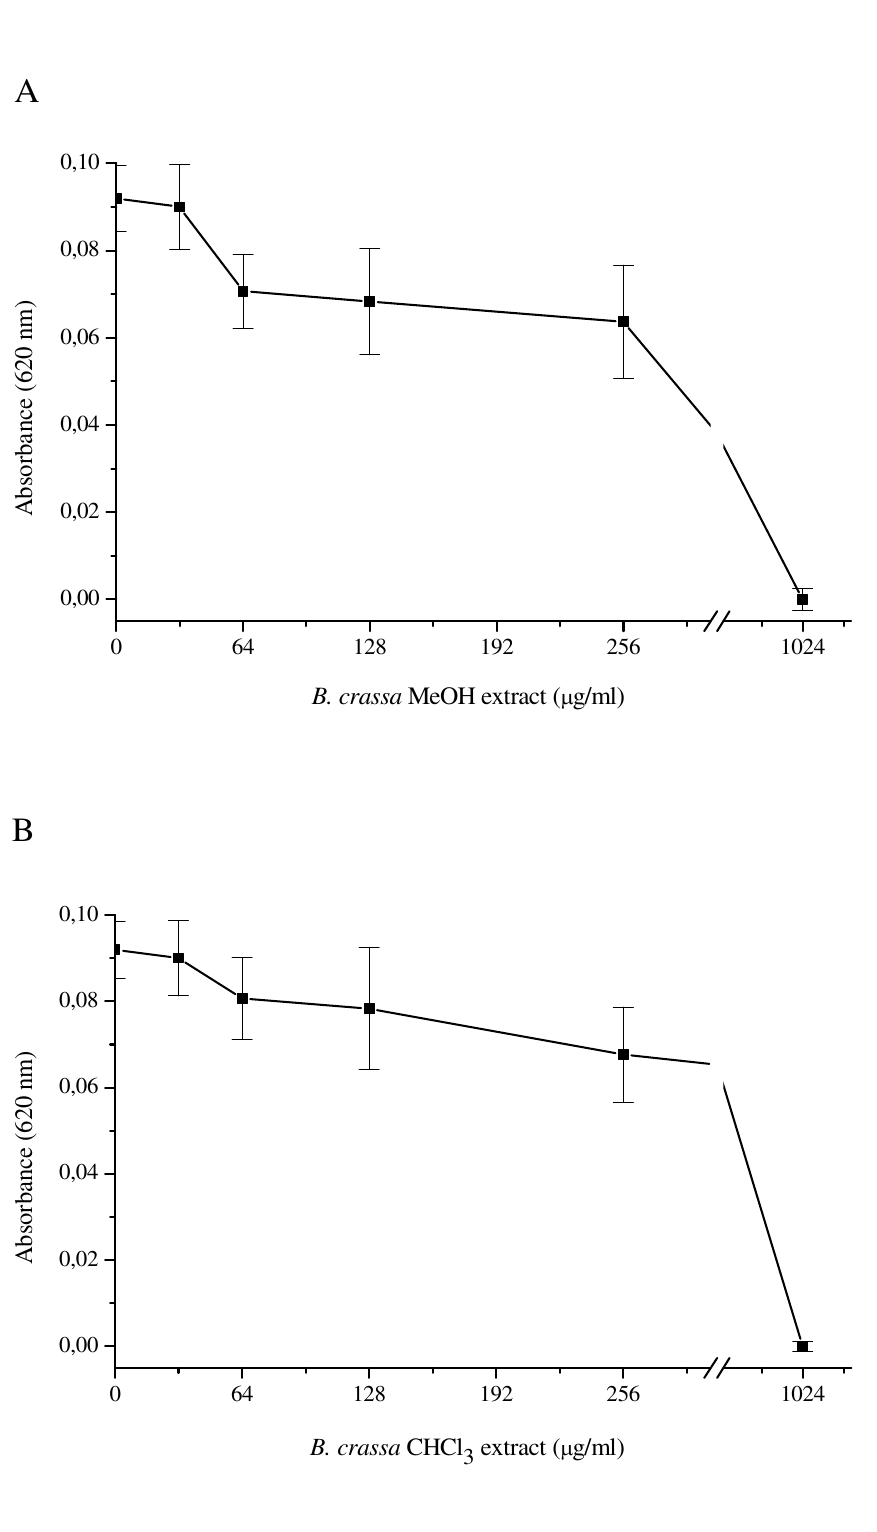
Effect of the MeOH (A) and CHCl following incubation for 72 h